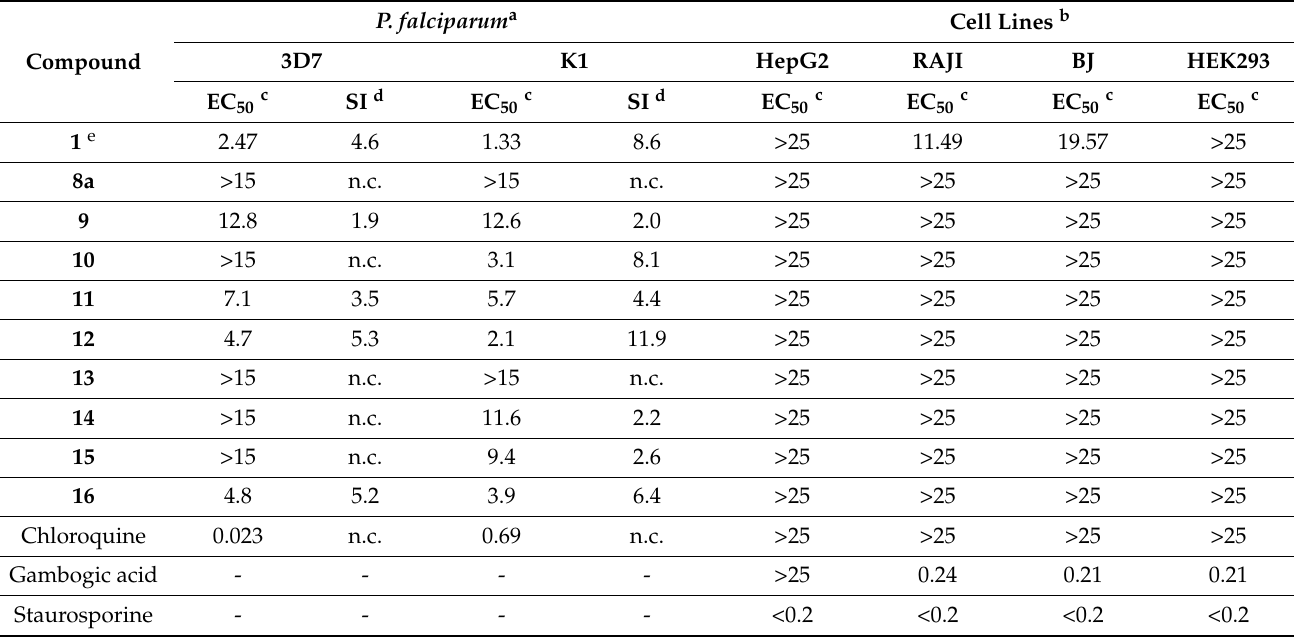
Table 3. Antiplasmodial activity and cytotoxicity (EC 50 - µ M) of ferruginol and sugiol analogs 8a, 9–16 on P. falciparum 3D7 strain, K1 strain, and HepG2, RAJI, BJ, and HEK293 cell lines. P. falciparum Compound